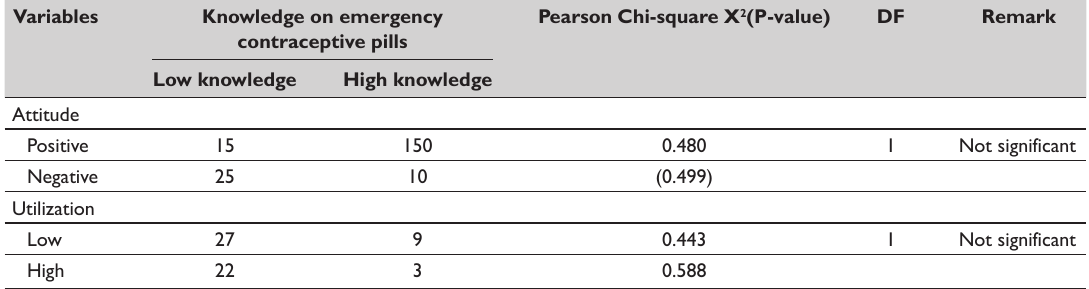
Table 6. Relationship between attitude, utilization and knowledge of emergency contraceptive pills